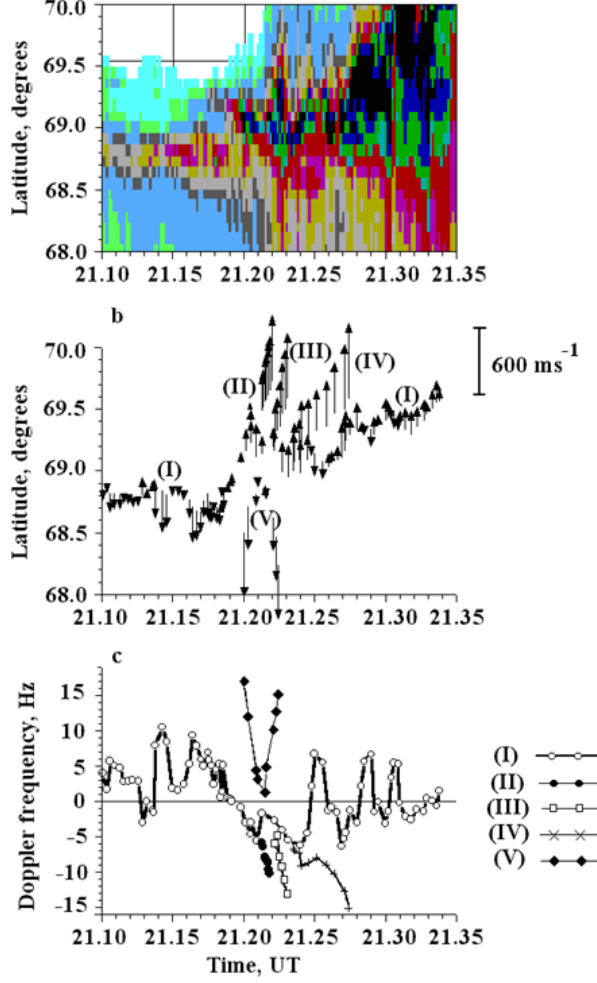
Fig. 8. Simulation results of Doppler frequency shifts on the Lon- don – Tromsø – St.Petersburg path at 9410kHz for the geophysical conditions on 16 February 1996, taking into account the velocity of auroral arc movements on the longitude of Tromsø (19.25 ◦ E) from the DASI keogram: (a) the DASI keogram; (b) velocities from the DASI keogram; (c) Doppler frequency shifts versus time, taking into account the velocities of auroral arcs shown in panel “b”, as well as electron density changes in the scattering volume from EIS- CAT UHF radar measurements shown in Fig.